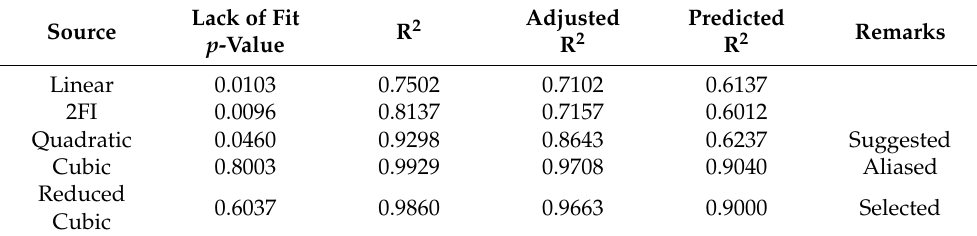
Table 6. Model summary